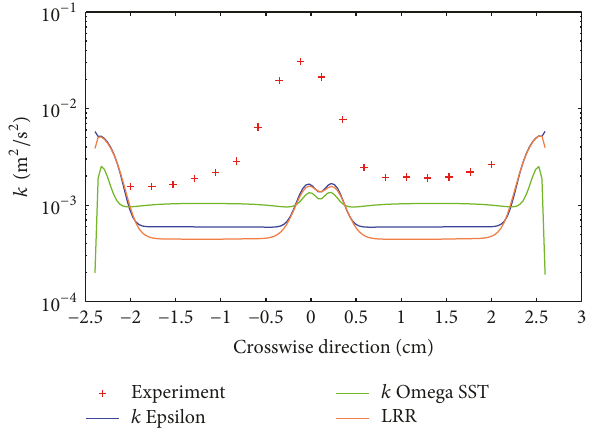
Figure 17: Turbulence kinetic energy calculated with different turbulence closure models at 𝑥 = 0.05 m from the splitter